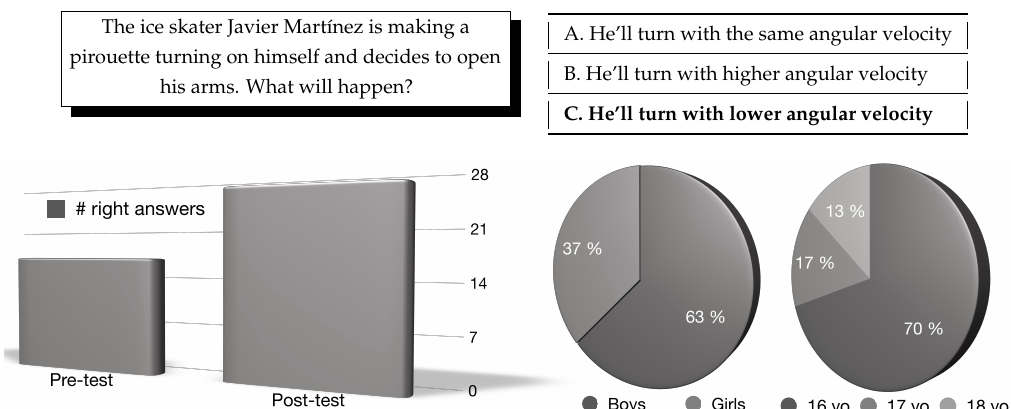
Figure 2. Top: One of the questions asked to the participants as part of the pre- and post-test. The option in bold face is the right one (C). Bottom: Statistical information about the participants in the study: correct answers in pre-test and post-test, gender, and age distribution ( yo stands for years old